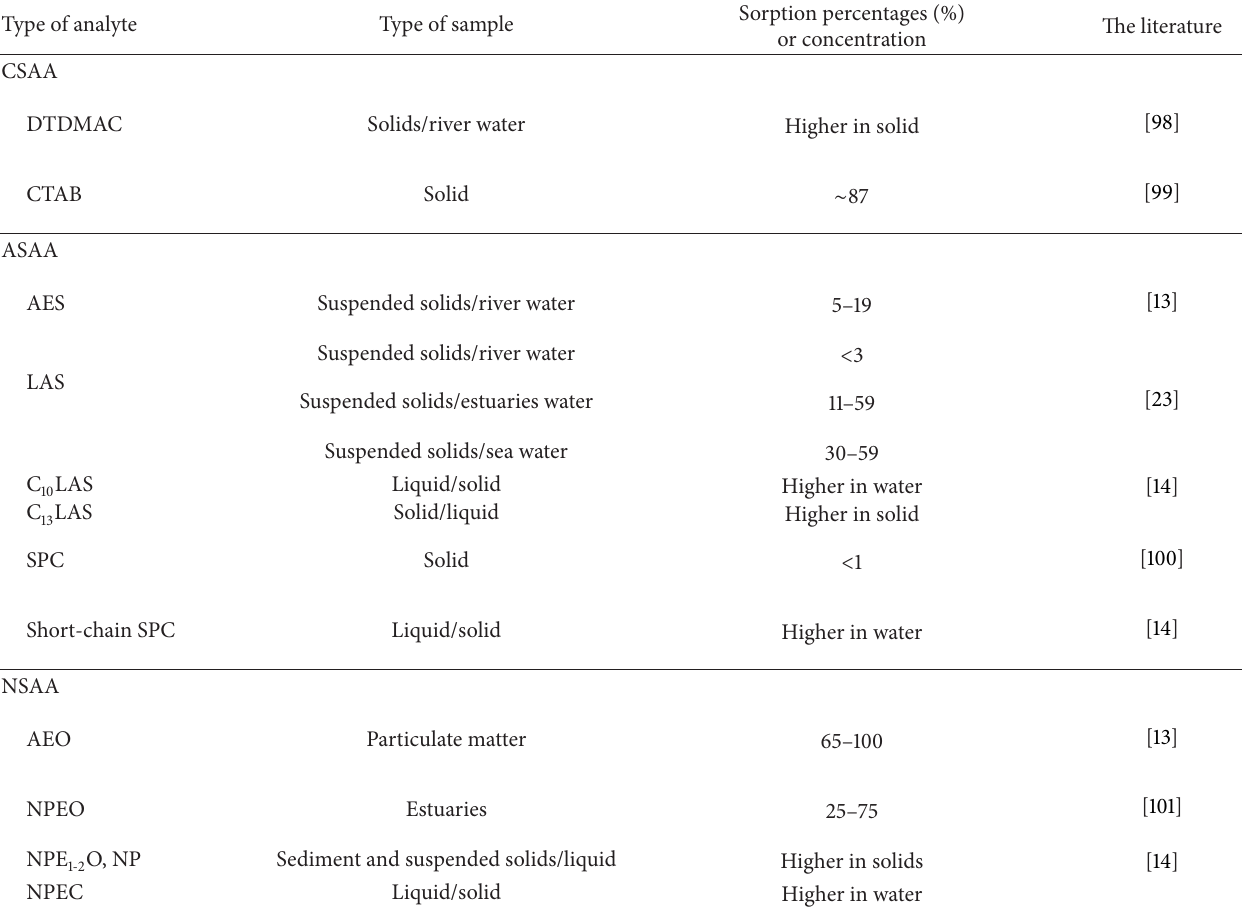
Table 2: Sorption percentages or occurrence of surfactants in environmental